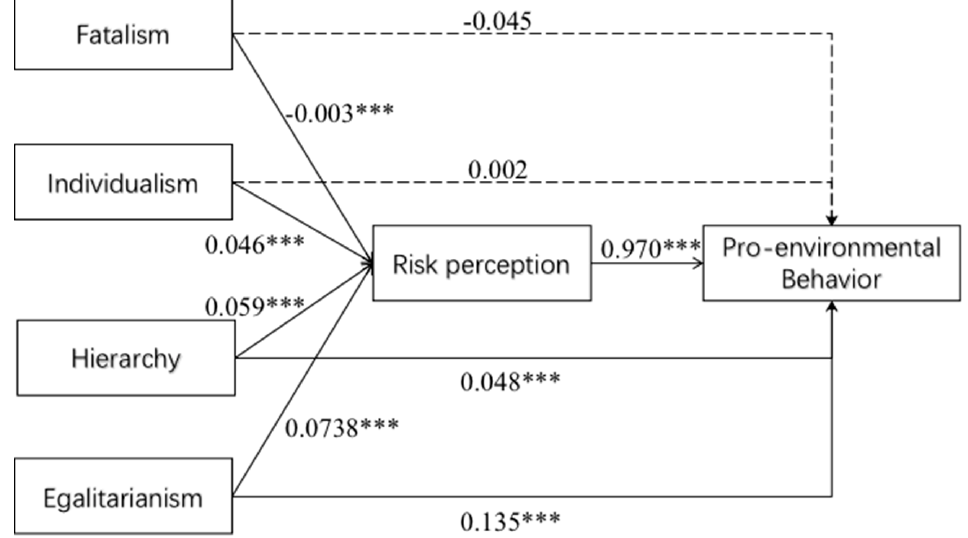
Figure 6. Path model explains the mediating effect of risk perception on the relationship between risk culture and pro-environmental behavior,*** denotes significance level of 1%